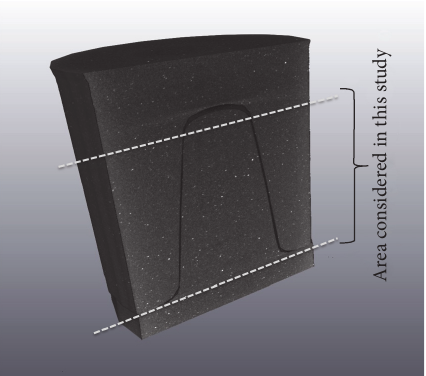
Figure 12: Area chosen to measure the gap in 3D illustrated on the conical